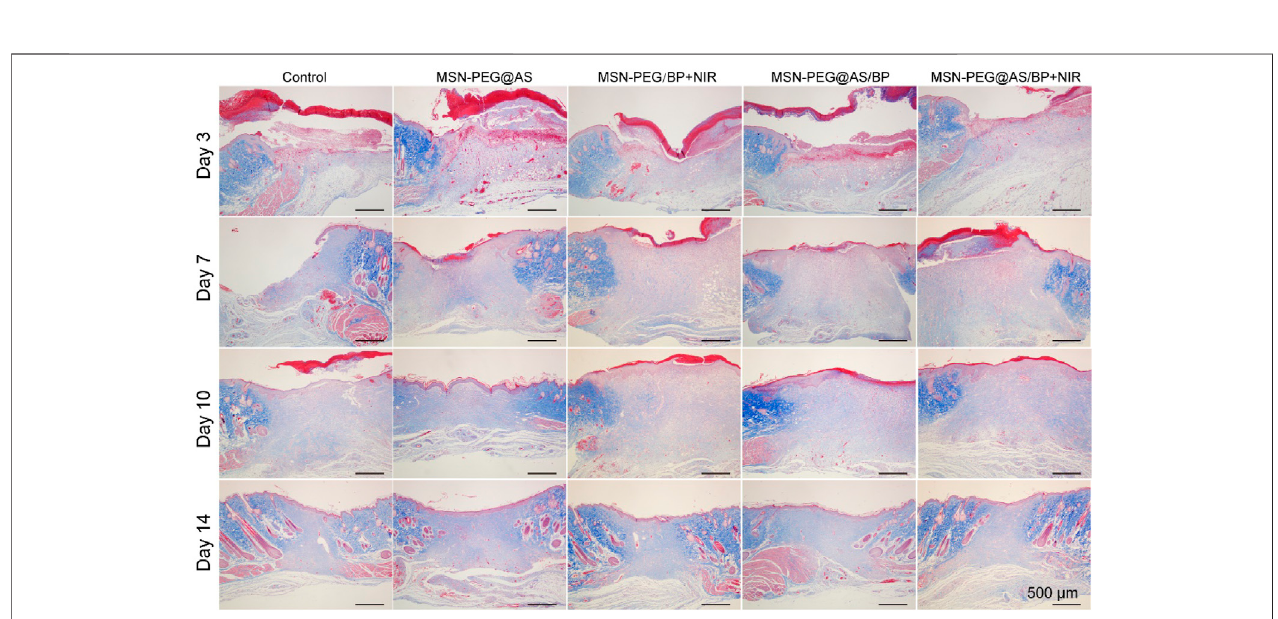
FIGURE 6| H&E staining of wound sections at days 0, 3, 7, 10, and 14 with different treatments (Control, MSN-PEG@AS, MSN-PEG@BP+ NIR, MSN-PEG@AS/ BP, and MSN-PEG@AS/BP + NIR).